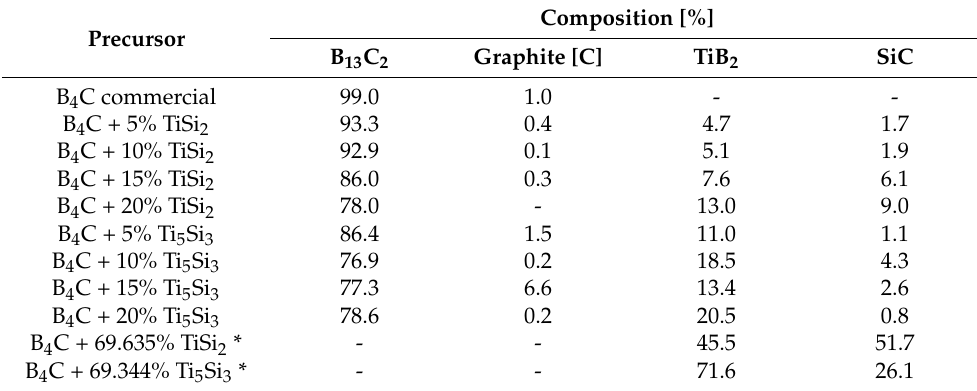
Table 2. The phase composition of the composites with Ti 5 Si 3 and TiSi 2 after sintering.